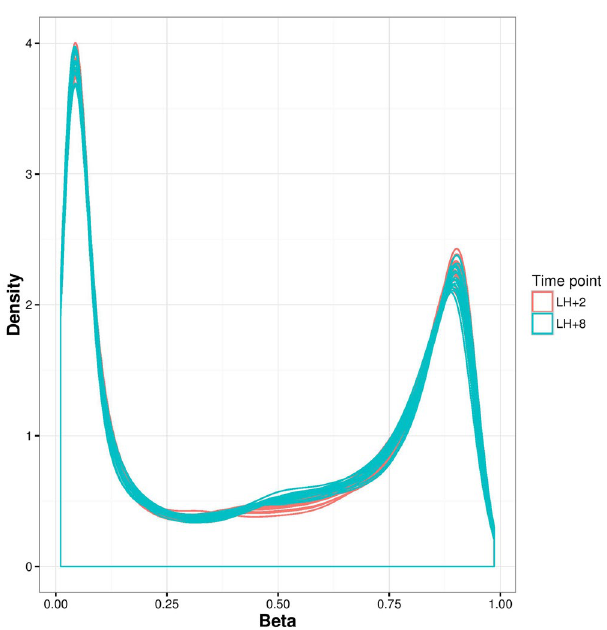
Figure 2. Density plot of DNA methylation levels (as β values) for pre-receptive (LH + 2) and receptive (LH + 8) endometrium samples from 17